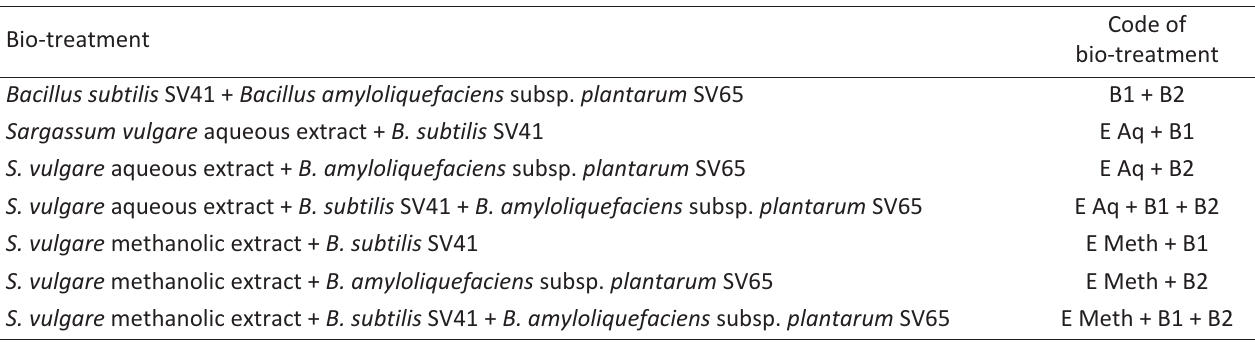
Table 2 ­ The seven combined bio­treatments tested